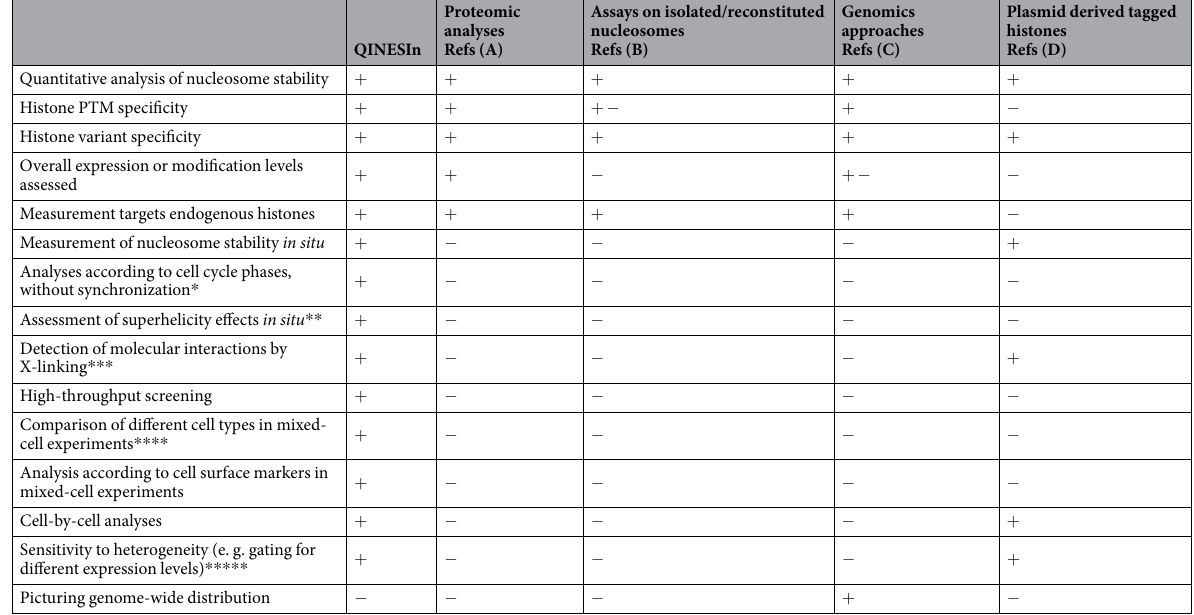
Table 1. Comparison of QINESIn with other methods available for the examination of molecular features related to nucleosome stability. “ + ” indicates that the particular approach has proved to be applicable for the corresponding purposes listed in the left column. “ + / − ” indicates that the particular approach provides semiquantitative or not readily extractable information. The asterisks refer to the data demonstrating the QINESIn features: * Supplementary Fig. S12; ** Fig. 4C–F; Supplementary Fig. S10A; *** Supplementary Fig. S13A,B; **** Figs 2D, 3D, Supplementary Fig. S2; ***** Supplementary Fig. S11A,B. References: (A): 27,28,38,39,43 , (B): 2,18–26,32–37,45 , (C): 29–31,46 , (D): 40–44